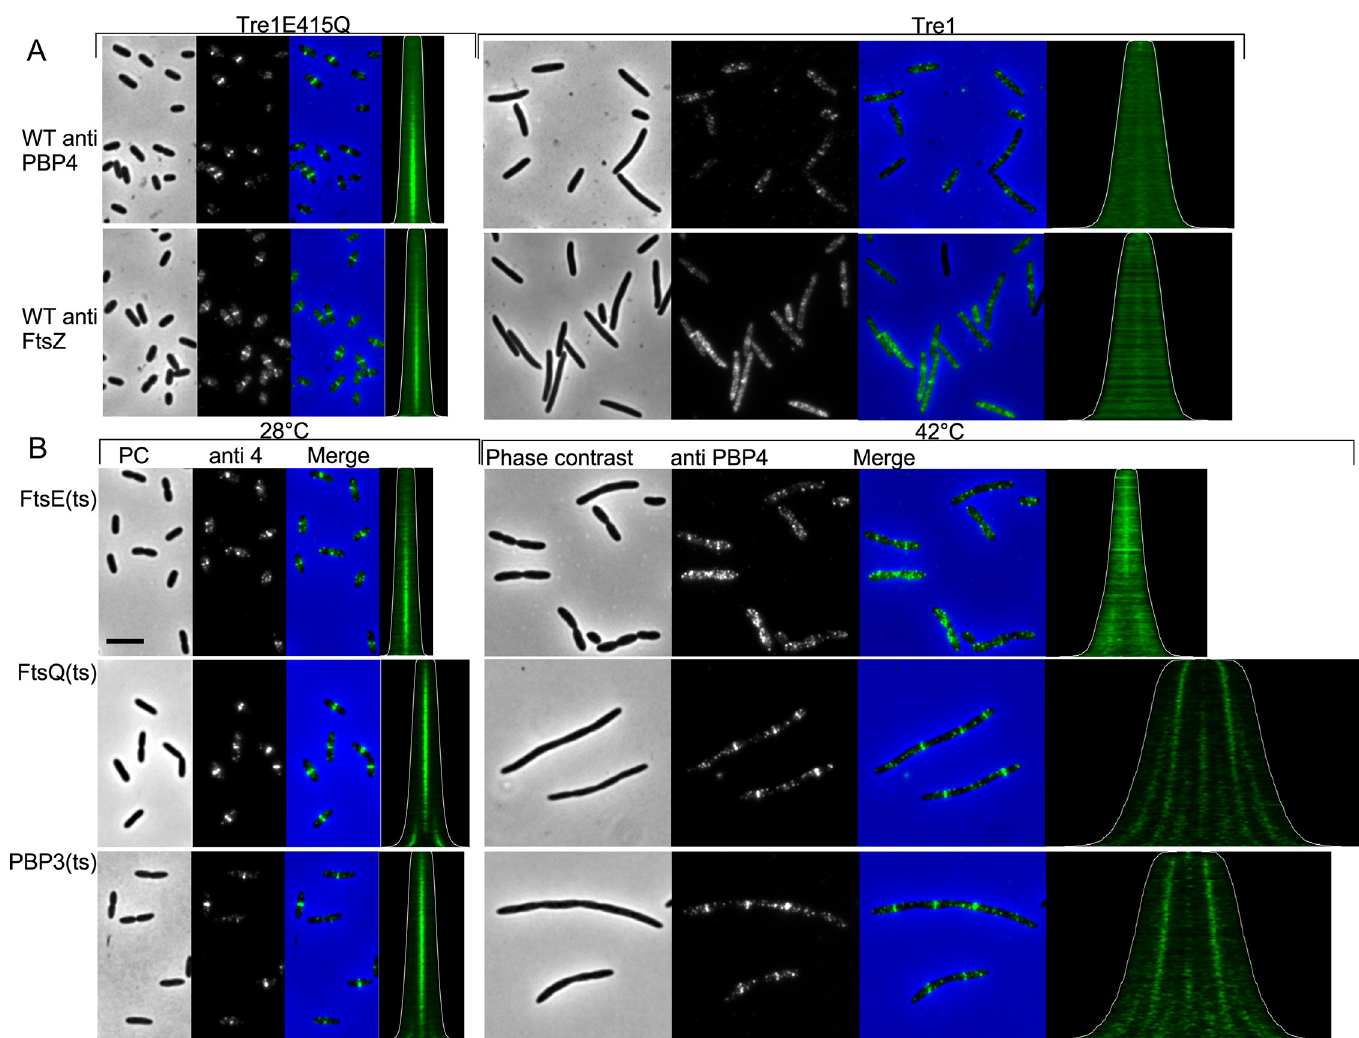
Fig 3. PBP4 localization is dependent on the presence of the proto-ring. A. MC4100 was transform with a plasmid that expressed either Tre1 that abolished the ability of FtsZ to polymerize by ADP-ribosylation of residue R174 or with the inactive variant Tre1(E415Q). Cells were grown in Gb1 medium at 28˚C and expression of the inhibitor was induced for 2 mass doublings (MD) with 0.15% arabinose. Subsequently, the cells were fixed and immunolabeled with antibodies against FtsZ or PBP4. From left to right: the phase contrast (PC), corresponding fluorescence image of the PBP4 labeling and the merged images are shown. In the demographs the cells are sorted according to cell length (contours in white). The number of cells analyzed were 3694 and 3756 for Tre1E415Q and 1275 and 1621 for Tre1 for anti FtsZ and anti PBP4, respectively. B. Isogenic strains of MC4100 producing different temperature sensitive (ts) versions of cell division proteins were grown to steady state in Gb1 medium at 28˚C and split in two parts. These were 1:4 diluted in prewarned medium and grown for two MD at either 28˚C or 42˚C. The cells were fixed, labeled with antibodies specific for PBP4 (anti4). From left to right: the phase contrast (PC), corresponding fluorescence image of the PBP4 labeling and the merged images at the permissive temperature, demograph of PBP4 fluorescence localization where cells are sorted according to their cell length (contours in white). This is followed by the same series from the non-permissive temperature samples. The number of cells analyzed were 2809 and 1576 for LMC515 FtsE(ts), 3833 and 1203 for LMC531 FtsQ (ts) and 3876 and 926 for LMC510 PBP3(ts), for the cells grown at 28˚C and 42˚C, respectively. The scale bar equals 5 μ m. Within one antibody staining the brightness and contrast of the samples is identical and therefore directly